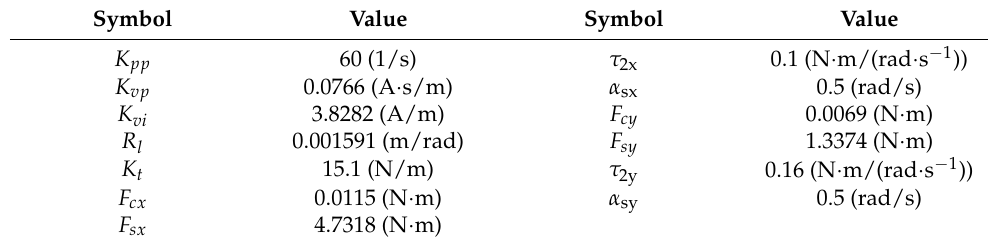
Table 6. System parameters in mechatronic system.